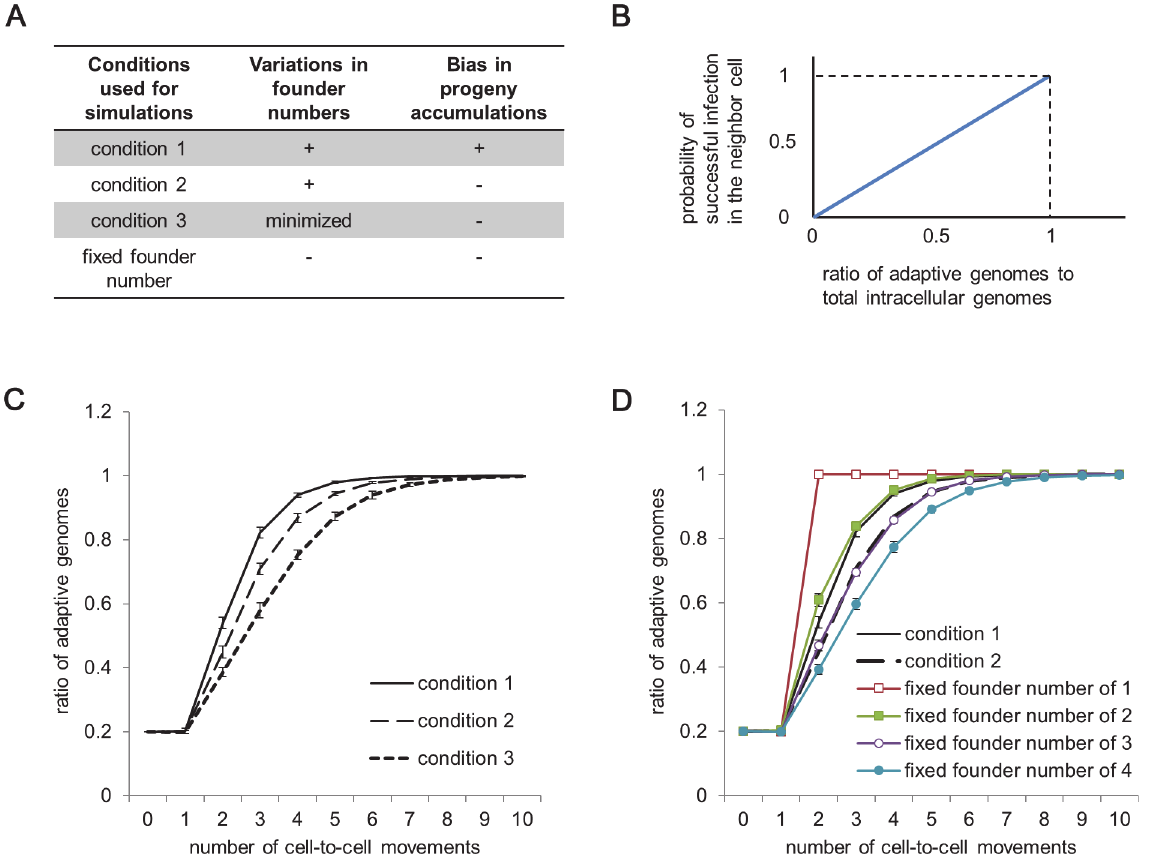
Fig 5. Simulation of the selection of trans -acting genes or elements at the tissue infection level. (A) A summary of the conditions used for the simulations. (B) Assumption of the probability of successful infection at a given ratio of adaptive genomes to the total number of intracellular genomes. (C) Comparison of the rate of adaptation under conditions 1 – 3. (D) Comparison of the rate of adaptation under conditions 1 and 2 with conditions assuming a fixed founder number and equal progeny accumulation. Data in panels C and D are presented as means ± SE, which were calculated by bootstrap analysis of 1,000 simulated cells. An R script used to generate panels C and D is shown in S6 Text, and the data obtained by the authors are shown in S3